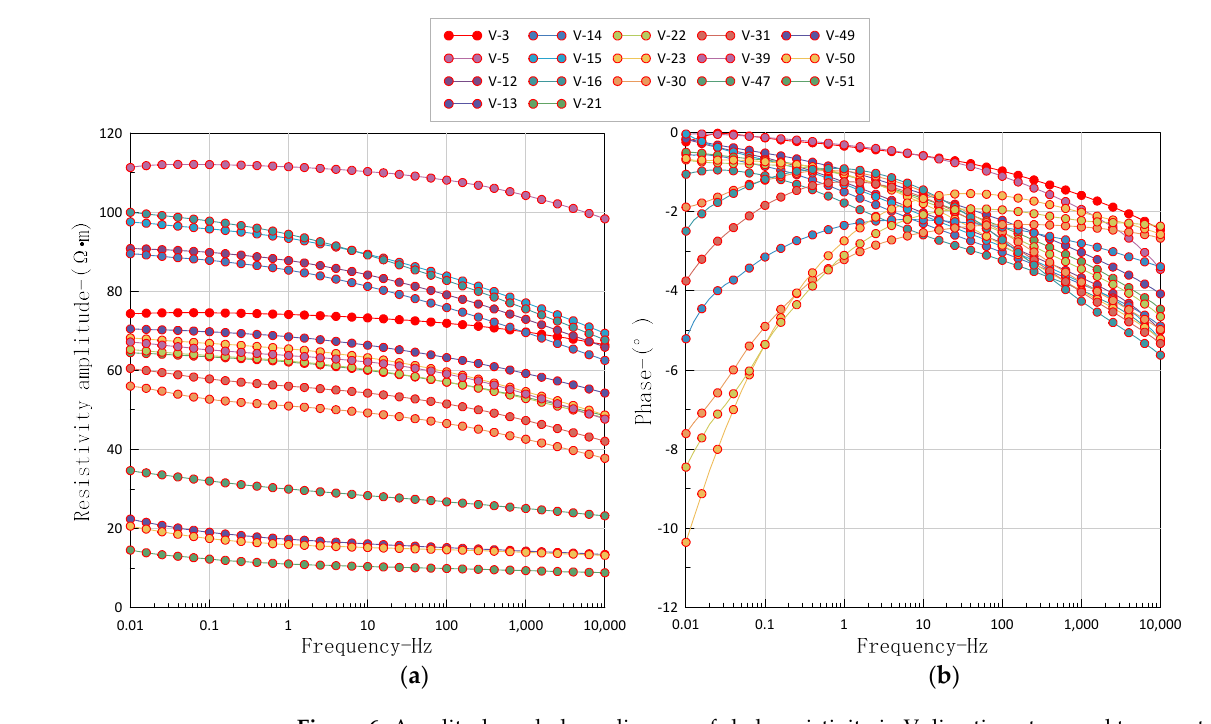
Figure 5. Amplitude and phase diagram of shale resistivity in H direction at normal temperature and pressure. ( a ) resistivity amplitude; ( b ) phase.